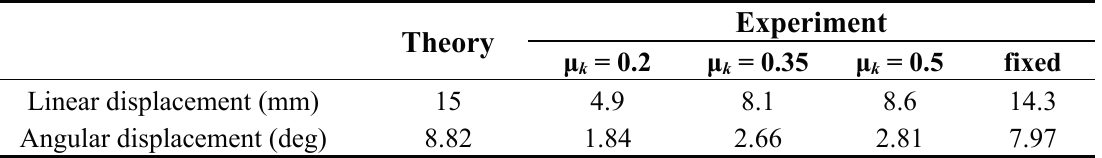
Figure 8. Profiles of input currents applied to the solenoid pair of the segmented robot ( a ) for the linear motion; ( b ) for the right-turning motion; ( c ) the captured images of the linear and right/left-turning motions of the two segments at 0.2 s. Table 2. Linear and angular displacements of the two-segmented robot for various friction conditions: the comparison of theoretical values with experimental